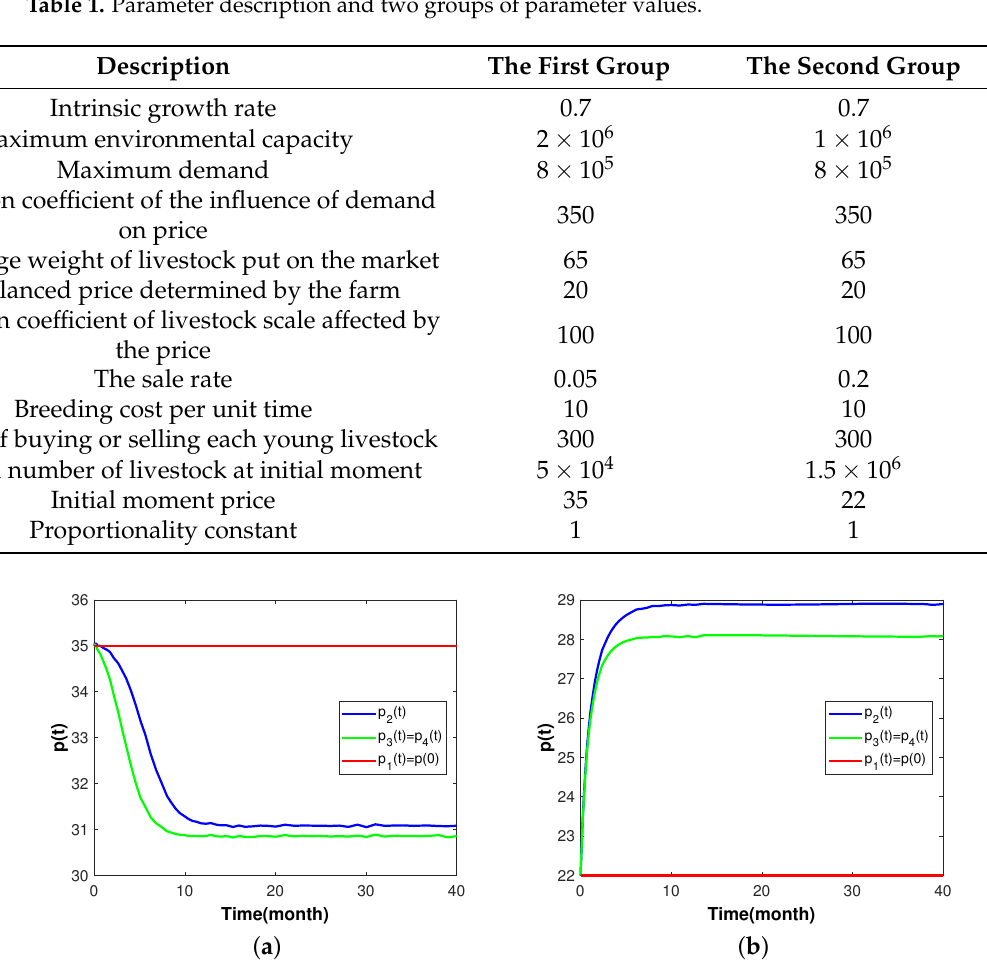
Figure 2. Changes in prices. ( a ) Based on the first group of parameters. ( b ) Based on the second group of